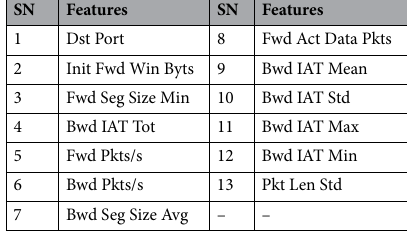
Table 3. Top-ranked selected features in the dataset.